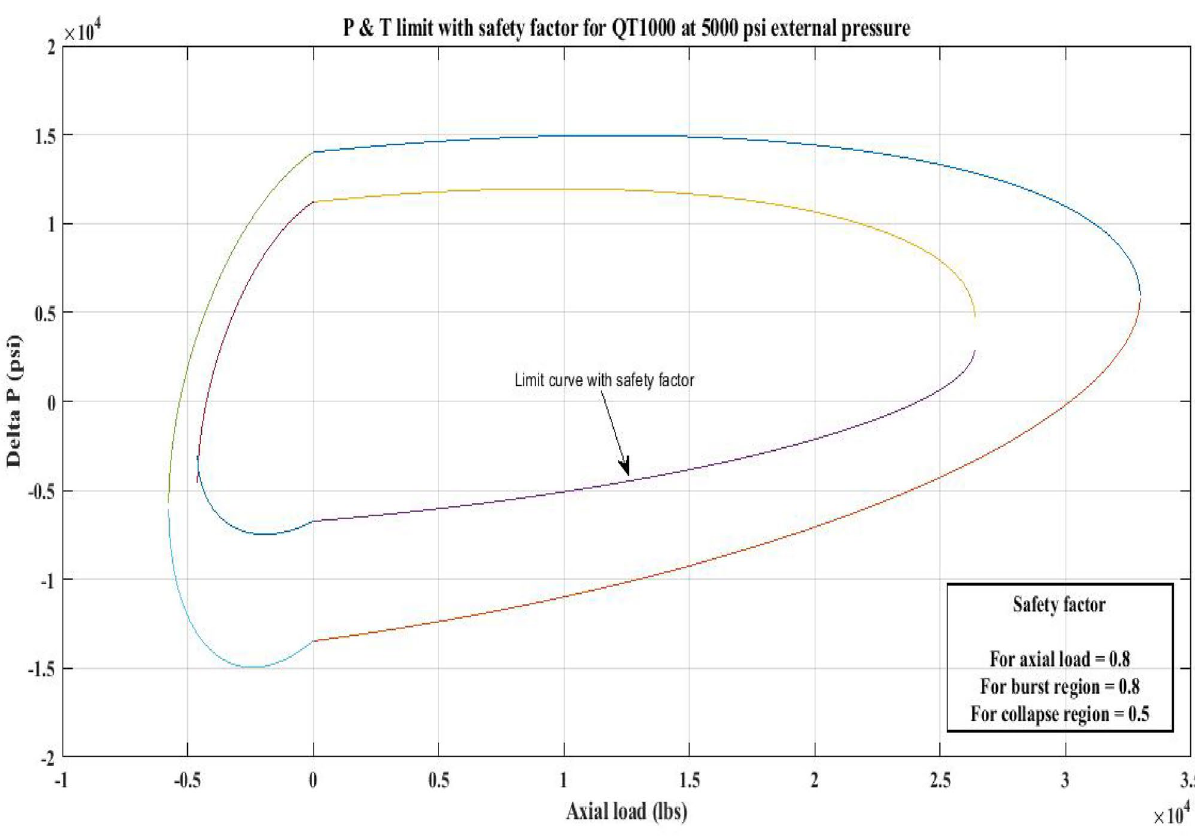
Figure 24. P and T limit with safety factor for QT 1000 at 5000 psi P o .